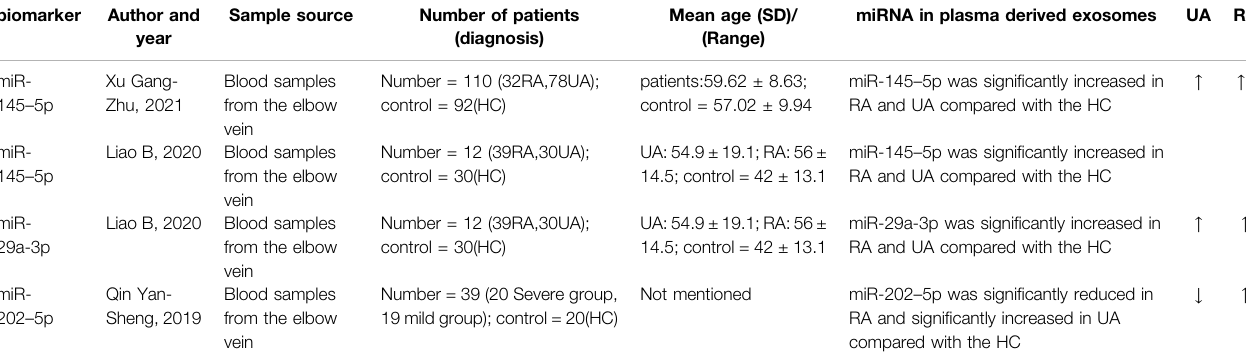
TABLE 1 | Summary of circulating exosome-derived miRNA in early diagnosis of